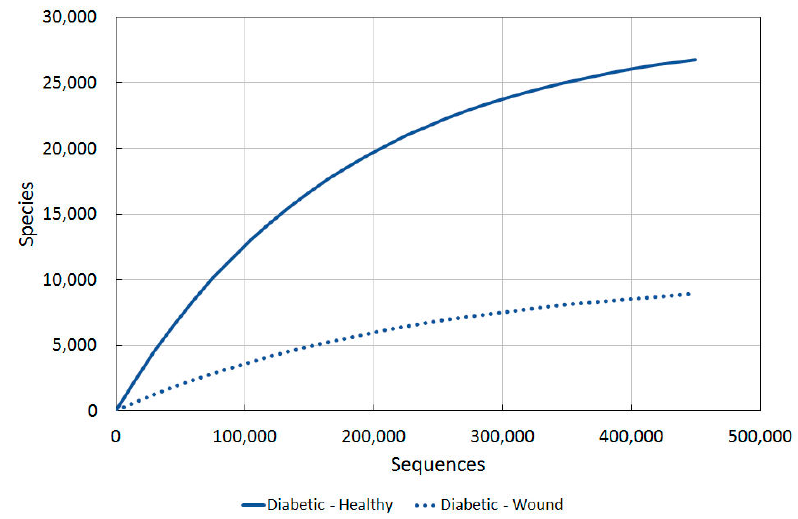
Figure 5. A comparison of bacterial diversity in diabetic ulcers and contralateral intact skin. Rarefaction analysis using Chao1 3% index.